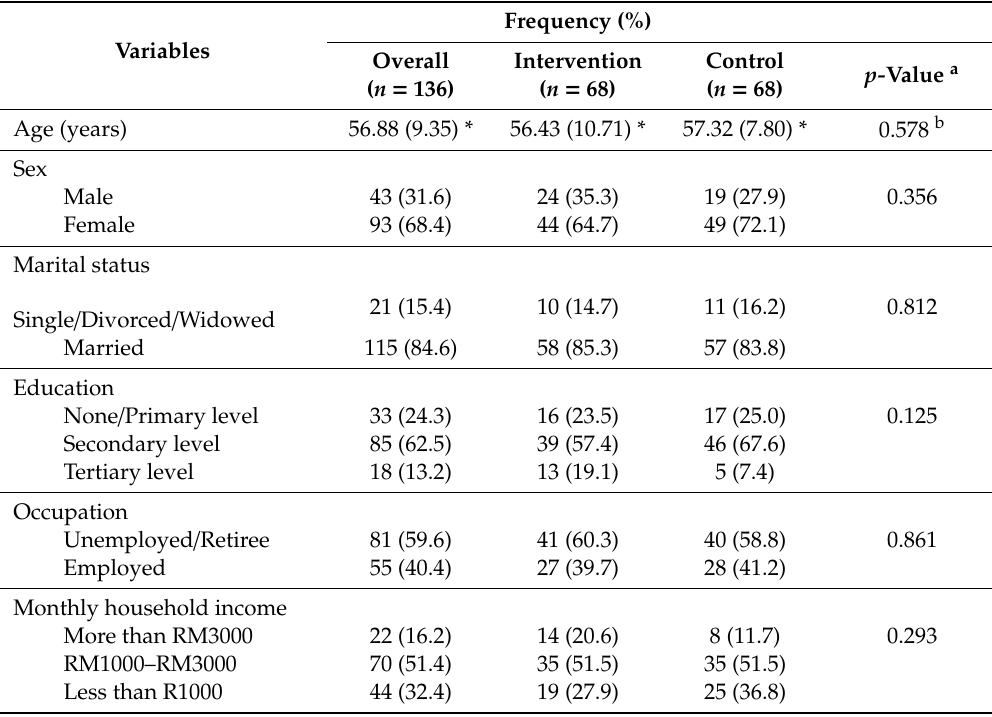
Table 1. Comparison of baseline sociodemographic characteristics between intervention and control groups ( n = 136).